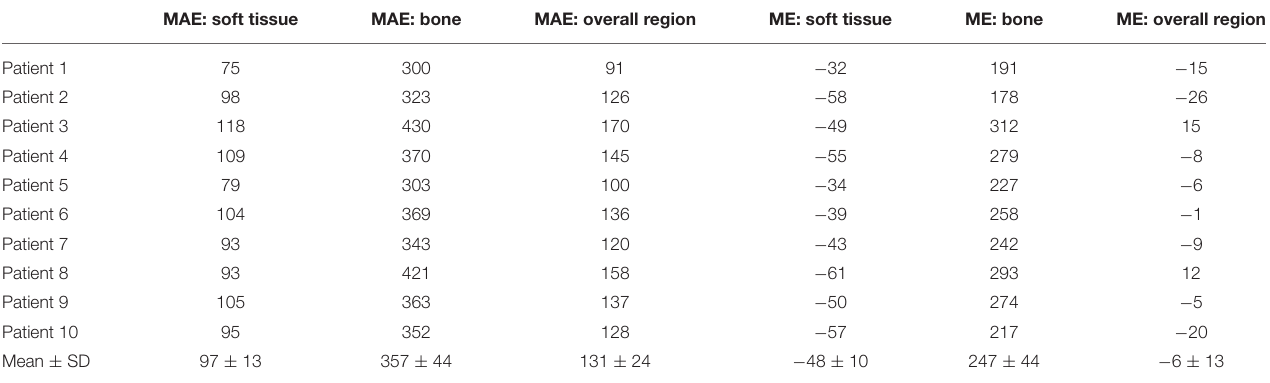
TABLE 1 | Summary of all 10 test patients. MAE: soft tissue MAE: bone MAE: overall region ME: soft tissue ME: bone ME: overall